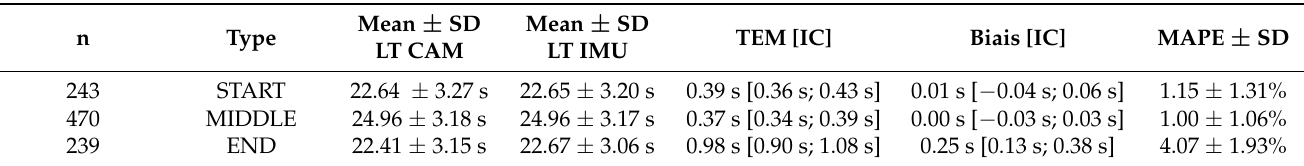
Table 8. Statistical agreement between lap times assessed by IMU and gold standard video according to lap time